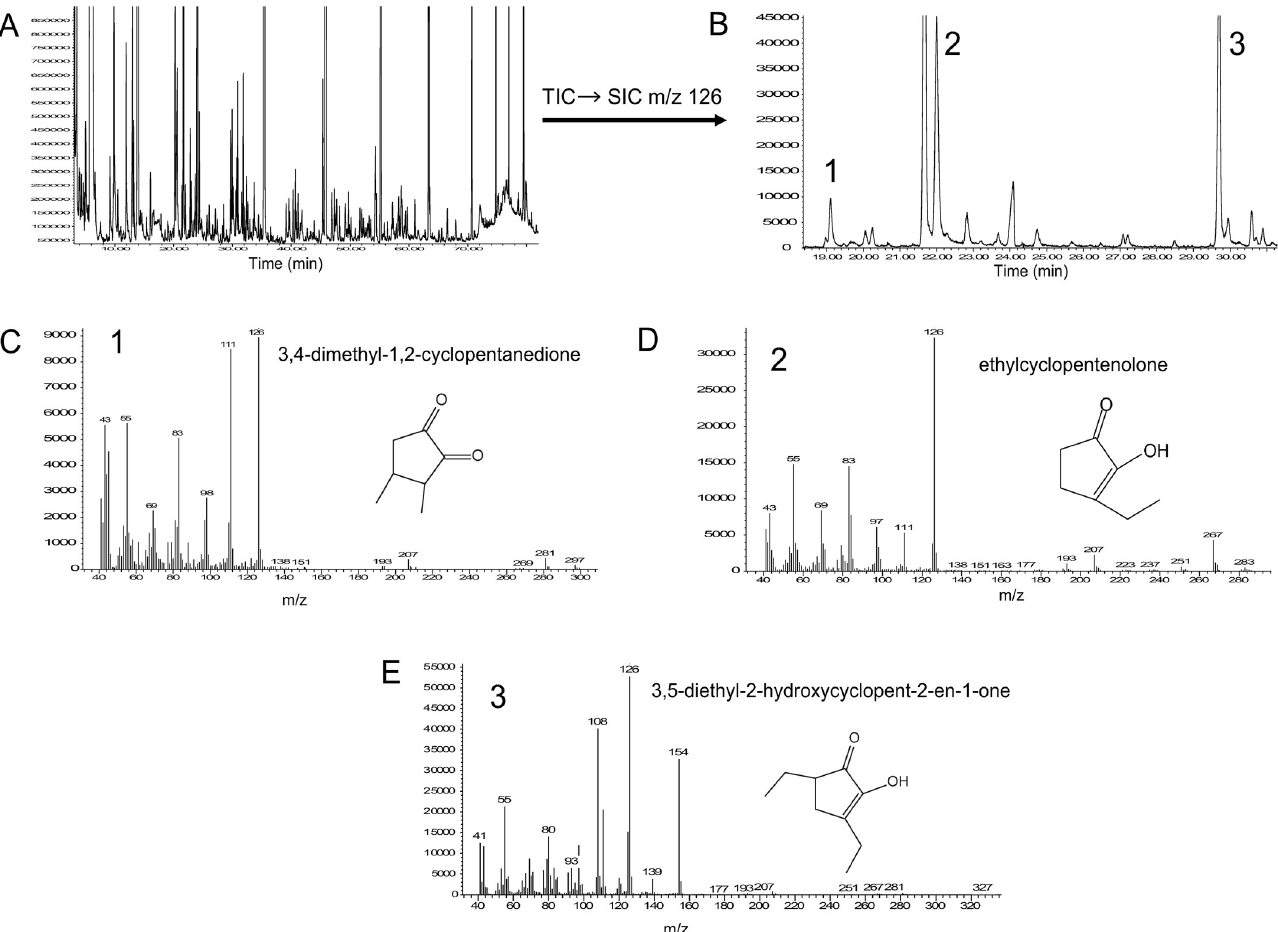
Fig 4. High loading compounds on sweat PC1 and their mass spectra (EI 70 eV). (A) Total ion chromatogram (TIC); (B) Post-run extracted m/z 126 single ion current chromatogram (SIC); (C) Compound 1, 3,4-dimethyl-1,2-cyclopentadione from SIC at retention time 16.1 min; (D) Compound 2, ethylcyclopentenolone from SIC at retention time 22.02 min; (E) 3,5-diethyl- 2-hydroxycyclopent-2-en-1-one from SIC at retention time 29.69